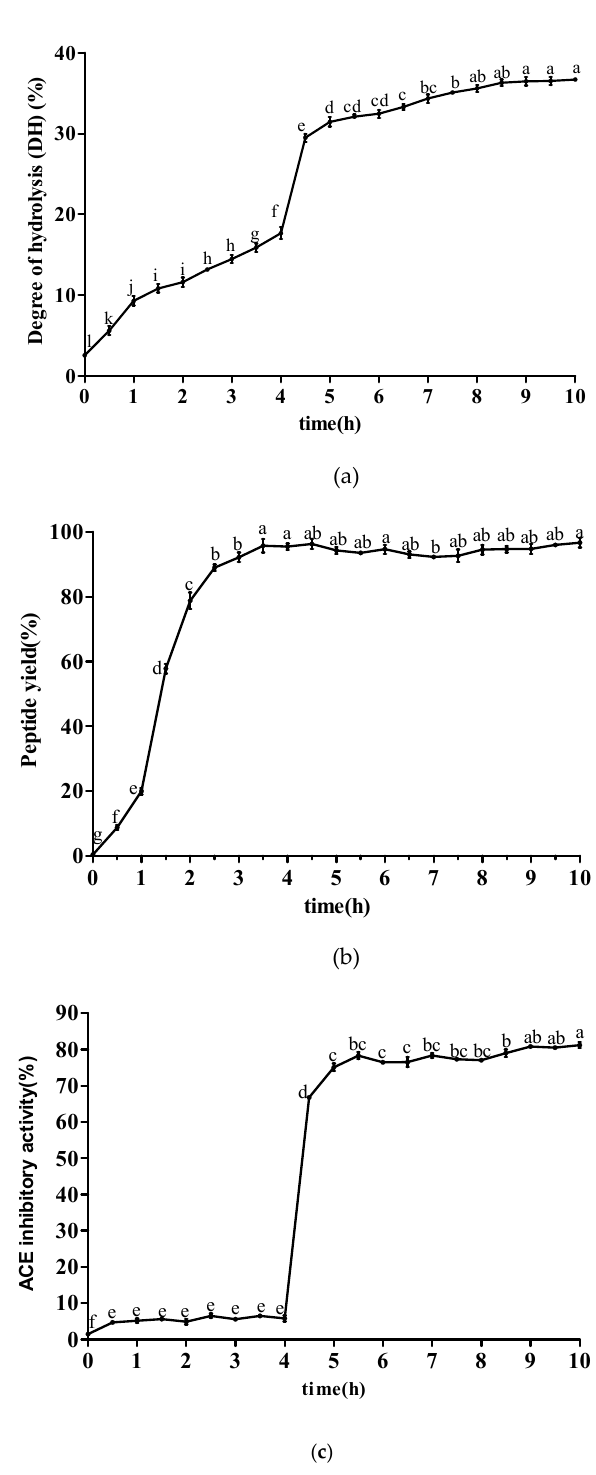
Figure 1. The changing rules of ACE inhibitory peptides at di ff erent time points during simulated gastrointestinal digestion. ( a ) Degree of hydrolysis changes at di ff erent time points during simulated gastrointestinal digestion. ( b ) The changes of peptide yield at di ff erent time points during simulated gastrointestinal digestion. ( c ) The changes of angiotensin I-converting enzyme (ACE) inhibitory activity at di ff erent time points during simulated gastrointestinal digestion. Data are expressed as the mean ± standard deviation ( n = 3) and di ff erent letters marked are significantly di ff erent by one-way analysis of variation multiple test ( p <